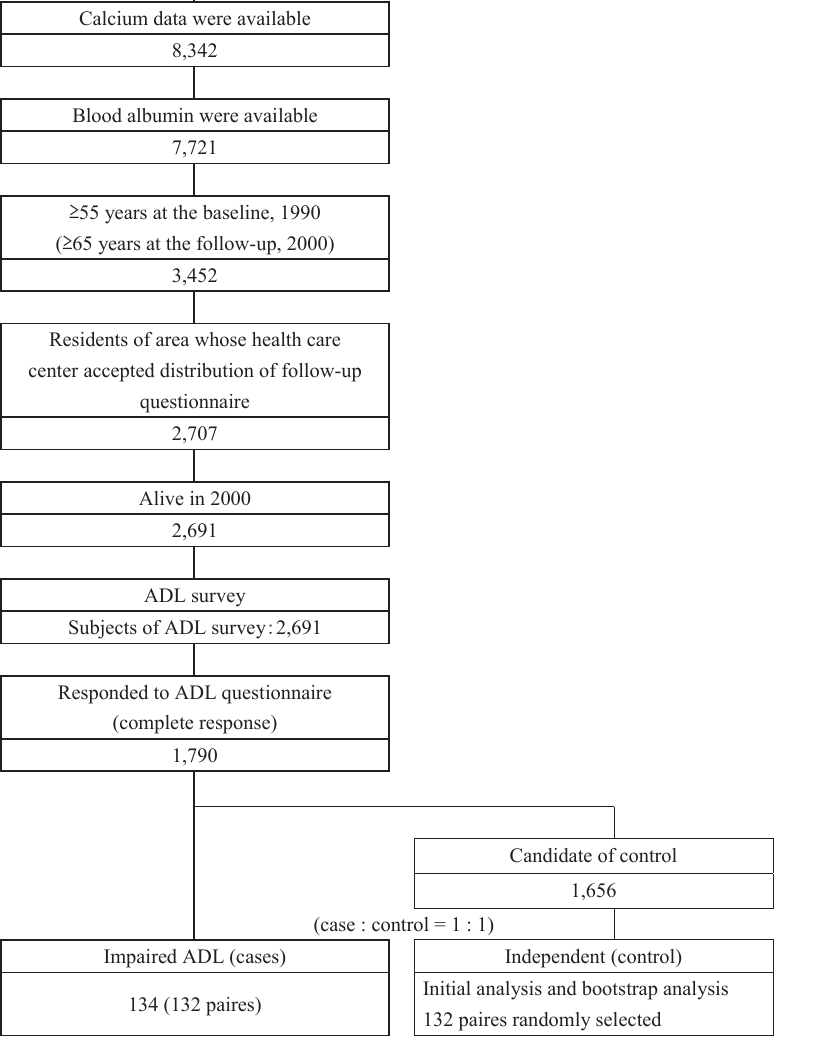
Figure 1. Flow chart of study participants. Participants who met the following criteria were included in the analyses: 1) Subjects who were 55 years old or more at baseline, 2) availability of calcium data, 3) availability of blood albumin data, 4) resident of area whose health care center accepted distribution of follow-up questionnaire, 5) alive at each time point, and 6) responded to ADL questionnaire. ADL, activities of daily living; NIPPON DATA90, The National Integrates Project for Prospective Observation of Non-communicable Disease And its Trends in Aged,